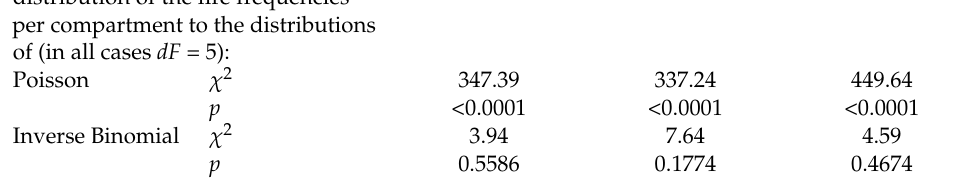
Table 1. The distribution parameters for the number of fires in the compartments of the Ilmensky